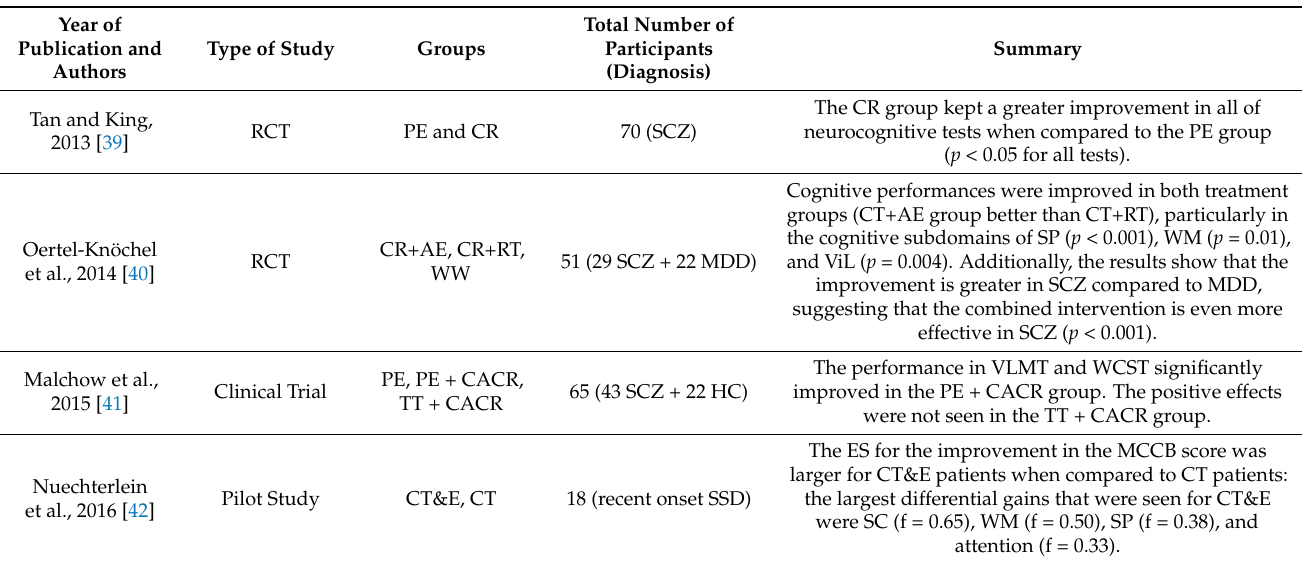
Table 2. Studies on the effect of physical exercise in combination with cognitive remediation on cognition in